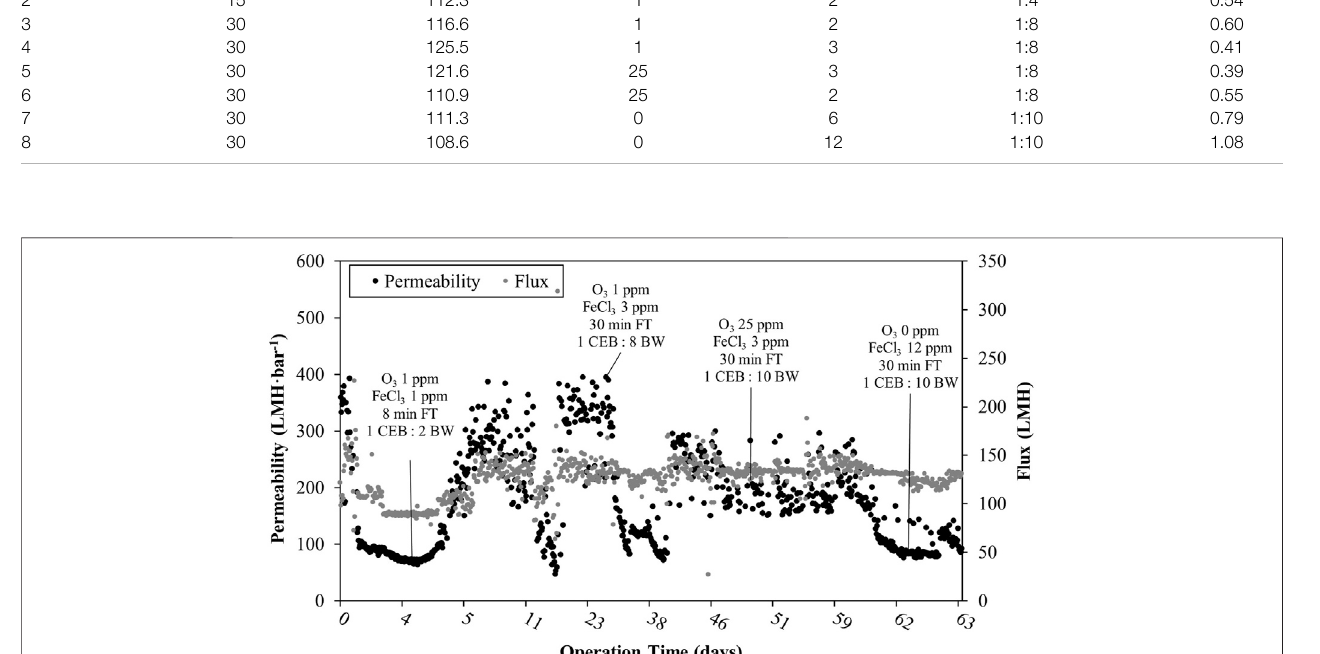
FIGURE 4 | Time-course of permeability and fl ux plotted for the long-term operation of the MF ceramic membrane, showing the operation conditions for 4 key stages.